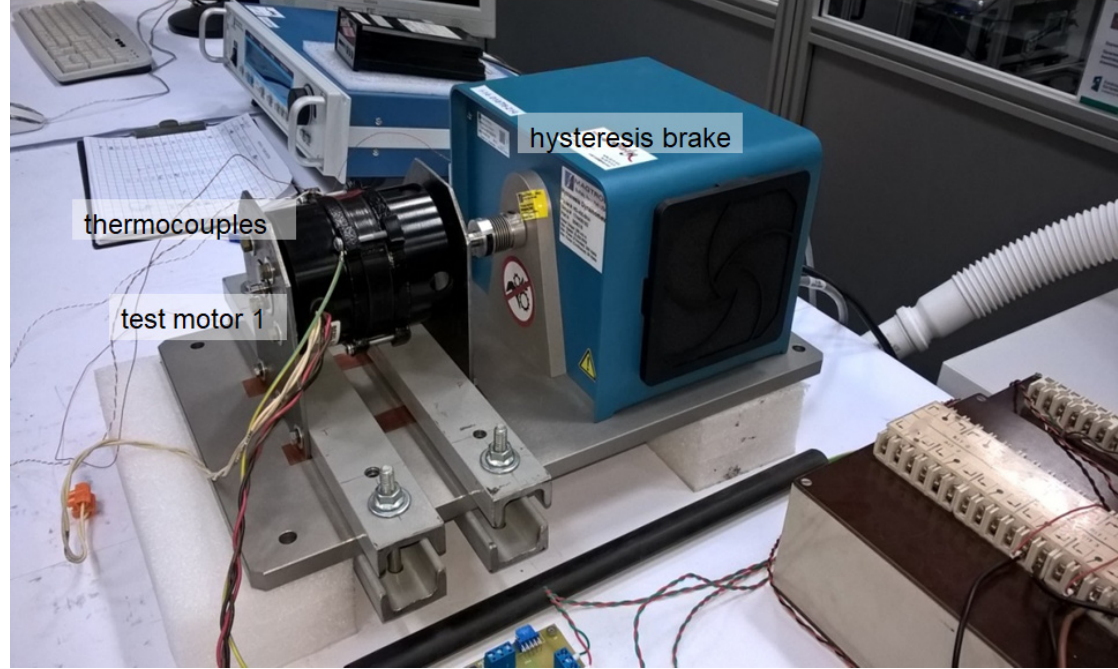
Figure 8. Experimental setup for measurements of core losses in investigated motors with test motor 1.